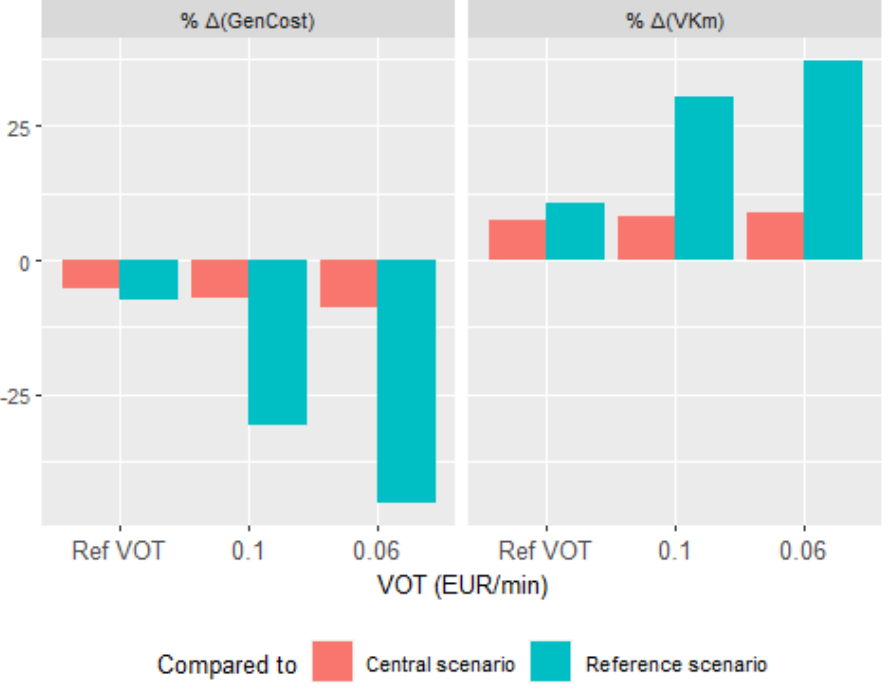
Figure 8. Sensitivity scenario for fuel consumption : impact on generalised cost and car